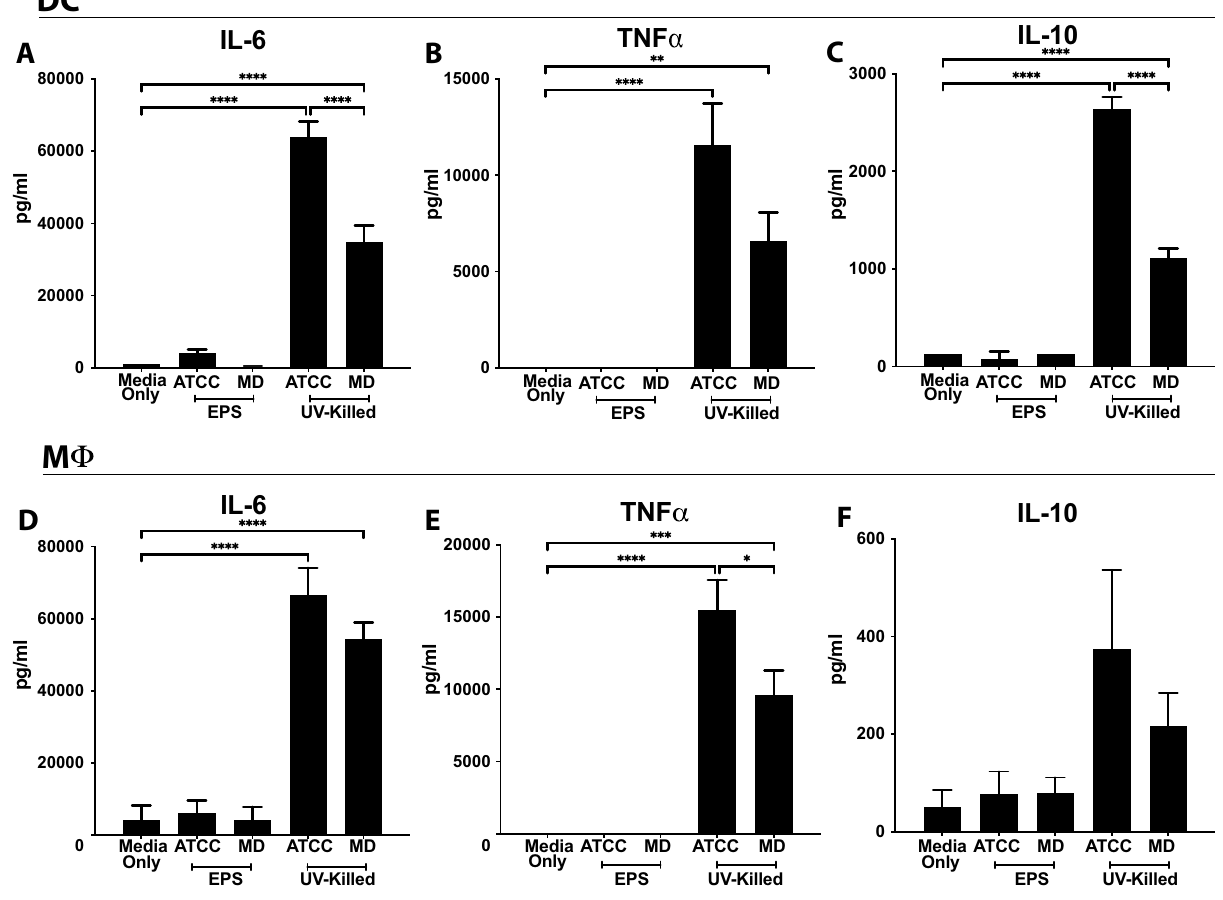
Figure 2. Bifidobacterium alters DC and MΦ cytokine secretion. DCs ( A–C ) or MΦ ( D–F ) stimulated with EPS or UV-killed ATCC25526 (ATCC) or UMB-MBP-01 (MD), and 24 h later supernatants analyzed